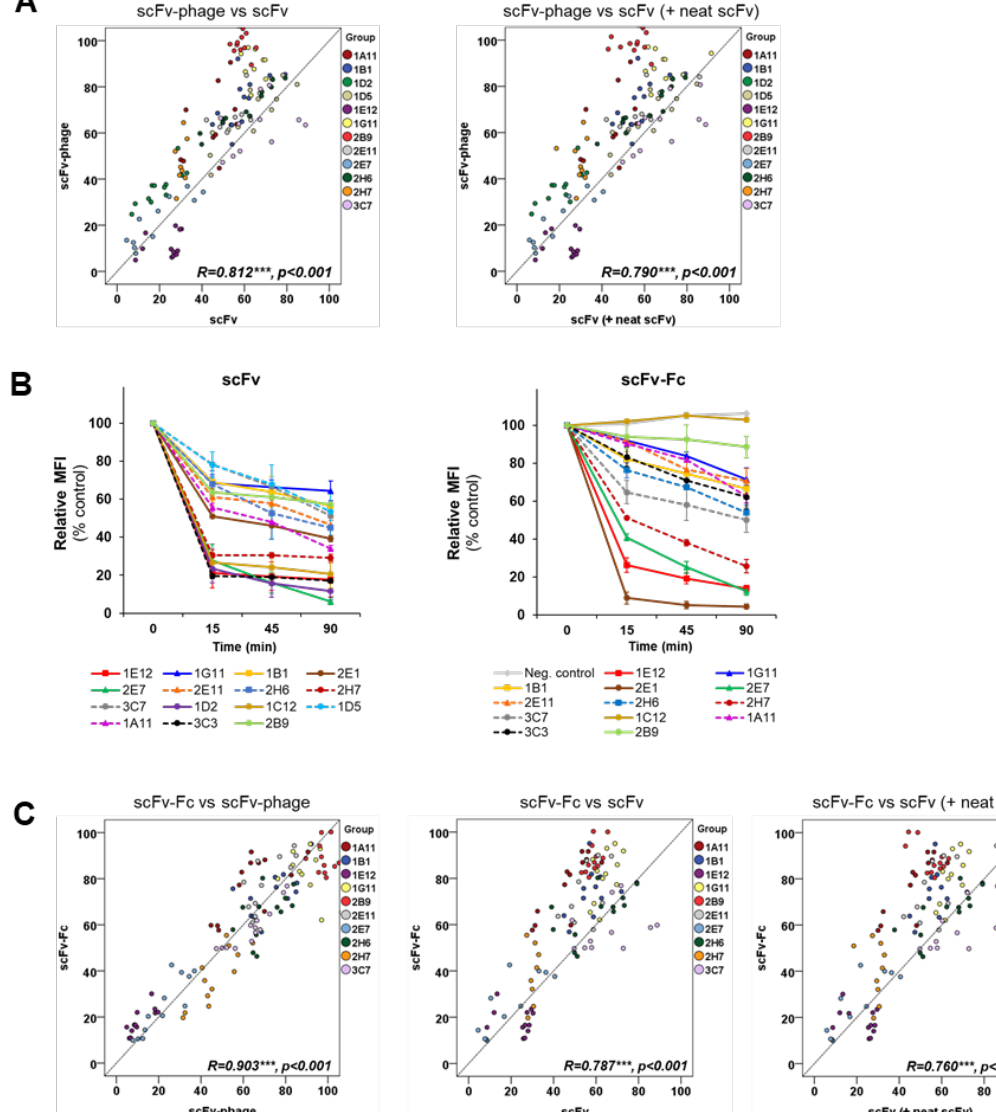
Figure 4. Comparative analysis of internalization of scFv-phage, scFv and scFv-Fc antibodies into MDA-MB-453. ( A ) Correlation analysis of internalization between scFv-phage and scFv (left) or combined scFv (neat and purified, right) formats derived from the same set of antibodies. X - and Y -axis are cell surface remaining antibodies. ( B ) Kinetics of internalization of scFv (left) and scFv-Fc (right). The results represent mean ± SEM from from at least four independent experiments. ( C ) Correlation analysis of scFv-Fc internalization in relation to scFv-phage, scFv and combined scFv (neat and purified).